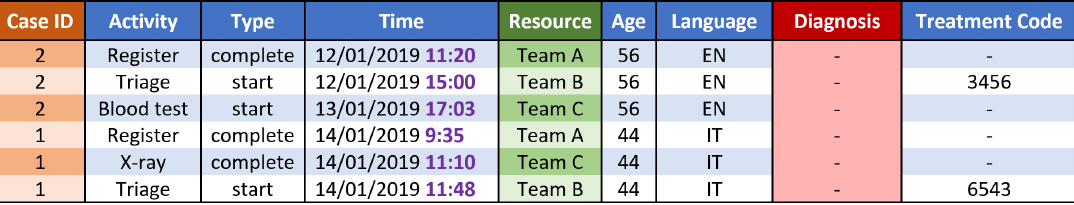
Figure 2. Application of data transformation techniques to the event log in Figure 1: Case ID: swapping; Time: noise addition; Resource: generalisation; Diagnosis: